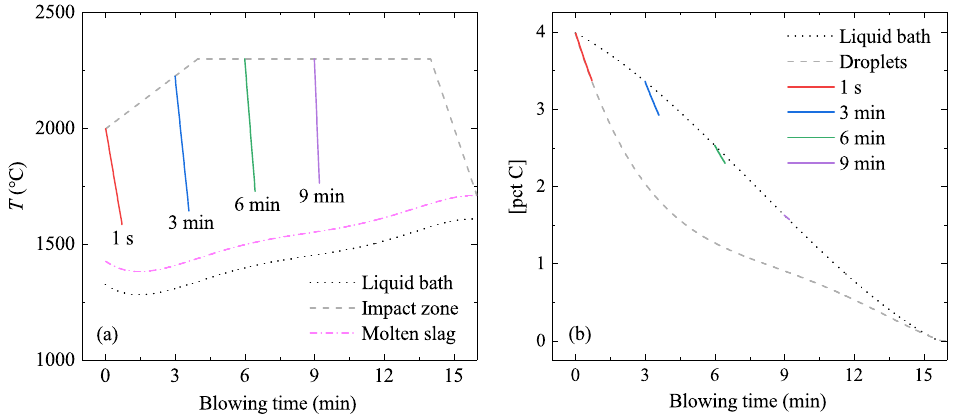
Figure 6. Change of ( a ) temperature and ( b ) [pct C] in various places in BOF. Solid curves were calcu- lated in the present study for ejected droplets generated at 1 s, 3 min, 6 min, and 9 min, respectively, during the oxygen blowing. Dash-dot curve is the estimated temperature of the slag [28]. Dotted curves are those for the liquid bath [22]. The dashed curve in ( a ) is the temperature at the impact zone [23]. The dashed curve in ( b ) is the [pct C] in ejected droplets reported by Dering et al. [22]. (color